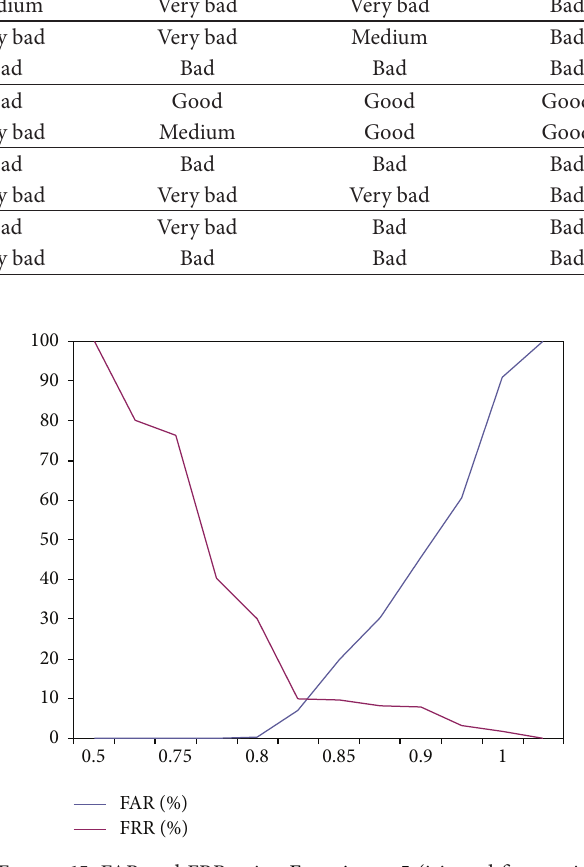
Figure 15: FAR and FRR using Experiment 5 (iris and fingerprint fusion based weighted sum rule